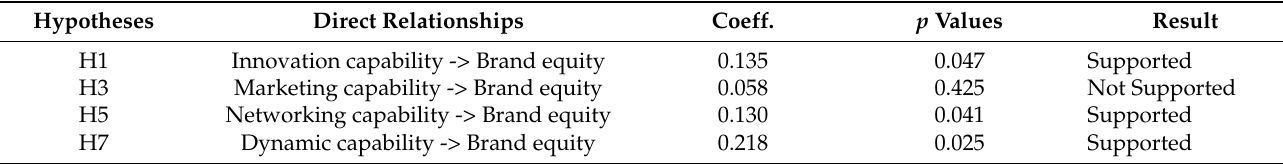
Figure 2. Structural model assessment. Table 6. Path Coefficients.